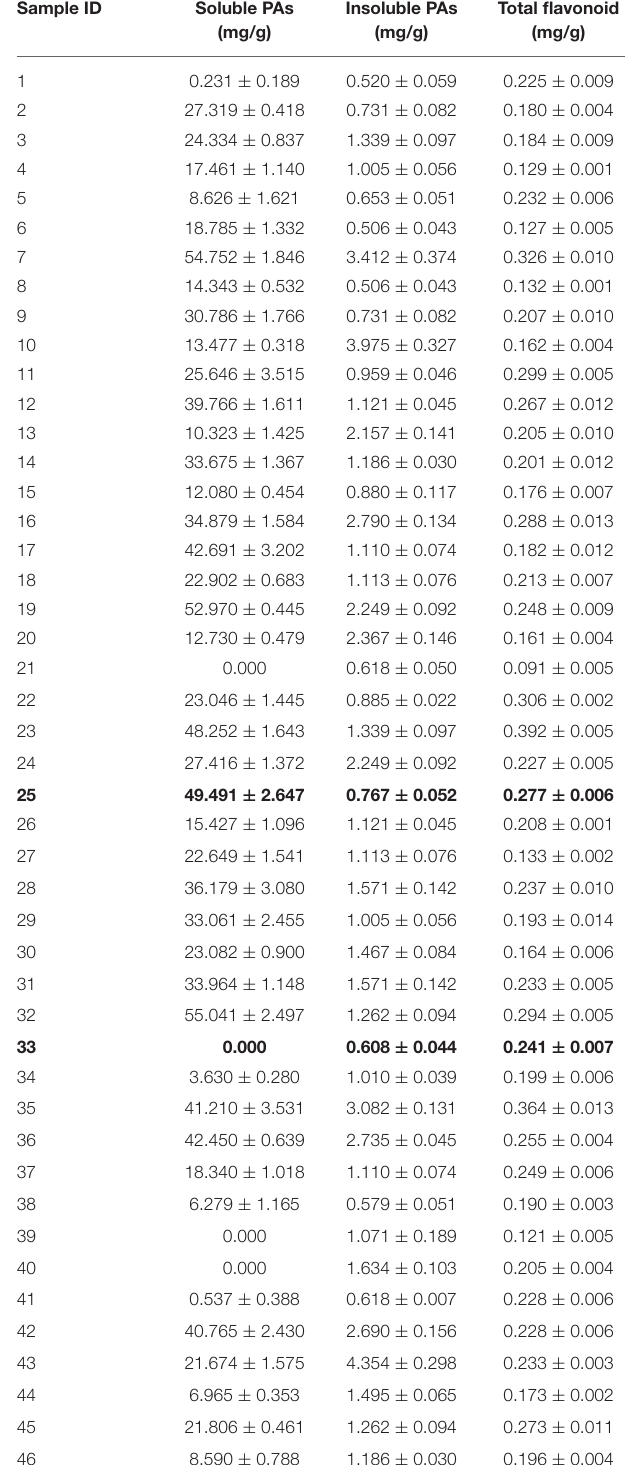
TABLE 1 | Content of soluble PAs, insoluble PAs, and total flavonoid determined in leaves of 46 sainfoin germplasm resources. Sample